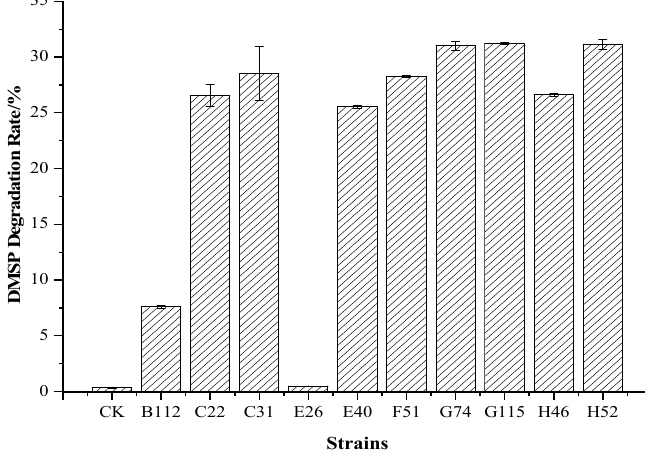
Figure 5. DMSP degradation by the QS bacteria. DMSP degradation was taken at 12 h by headspace gas chromatography (GC). CK was the blank control.